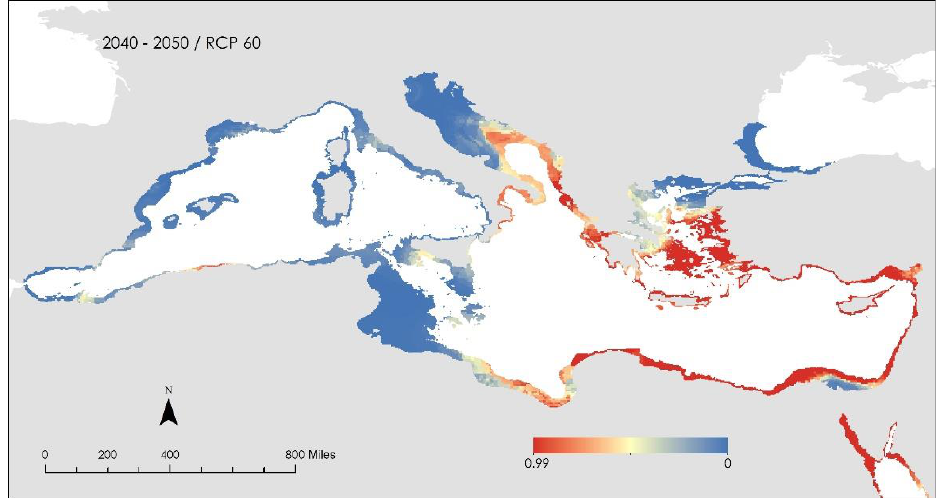
Figure 4. Lionfish potential distribution under RCP60 for the period 2040 – 2050.